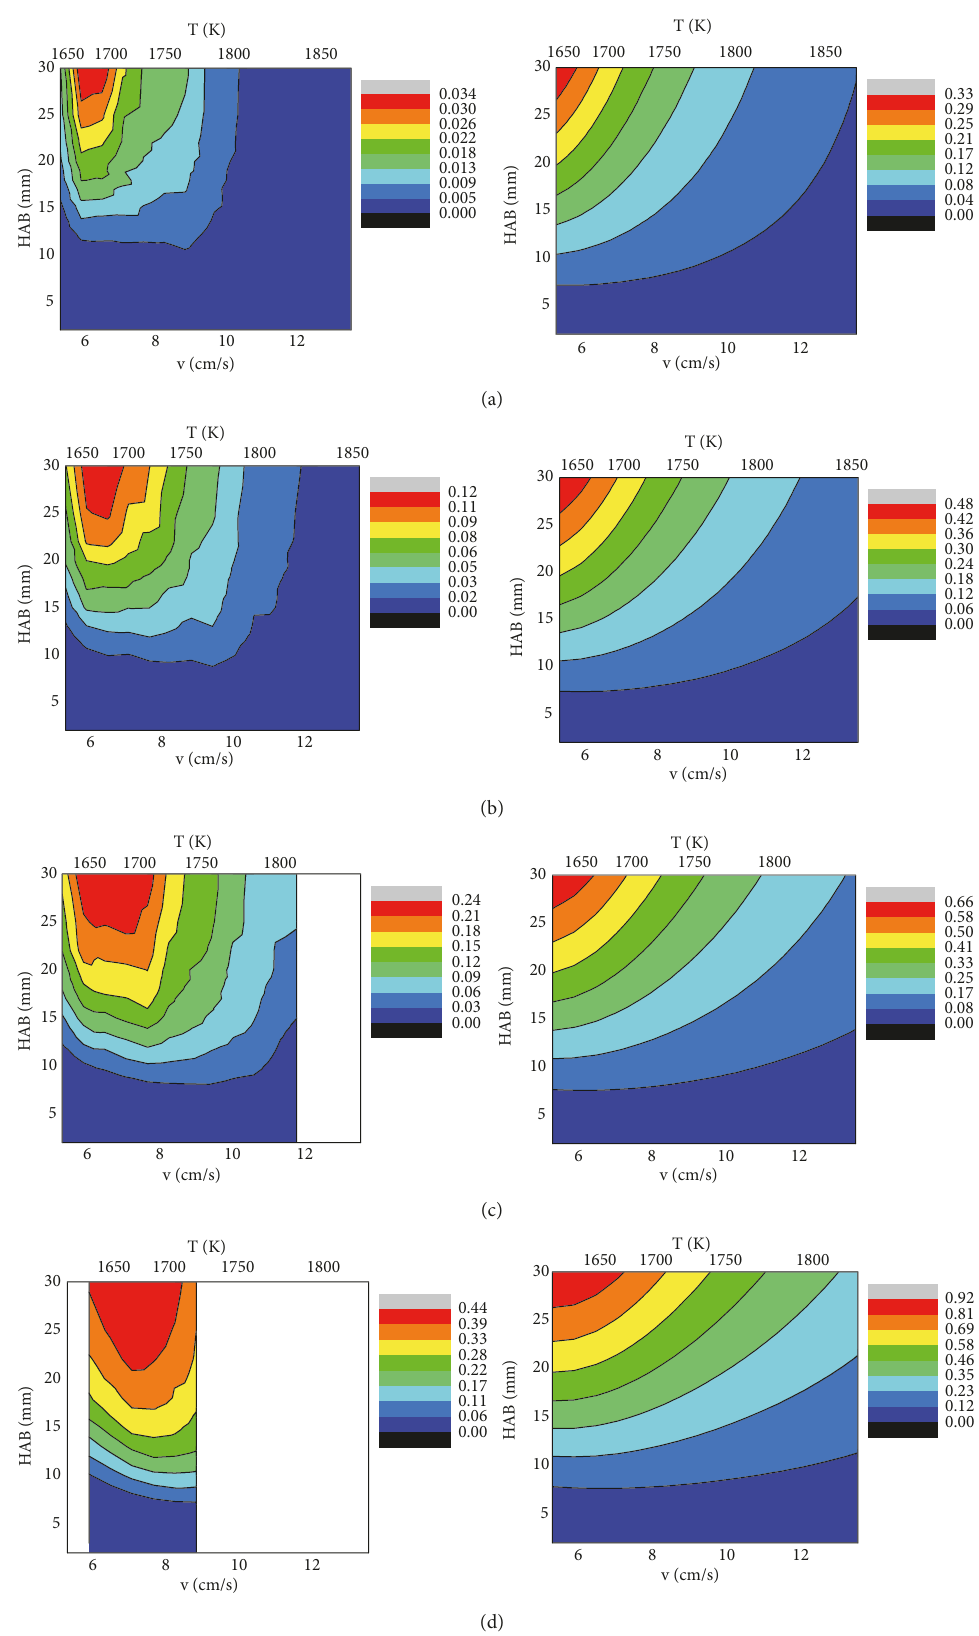
Figure 7: Contour plots of the measured (left) and calculated—using the Liu model—(right) soot volume fraction (ppm) as function of HAB and exit velocity V for equivalence ratios (a) 𝜙 = 2.0, (b) 𝜙 = 2.1, (c) 𝜙 = 2.2, and (d) 𝜙 =